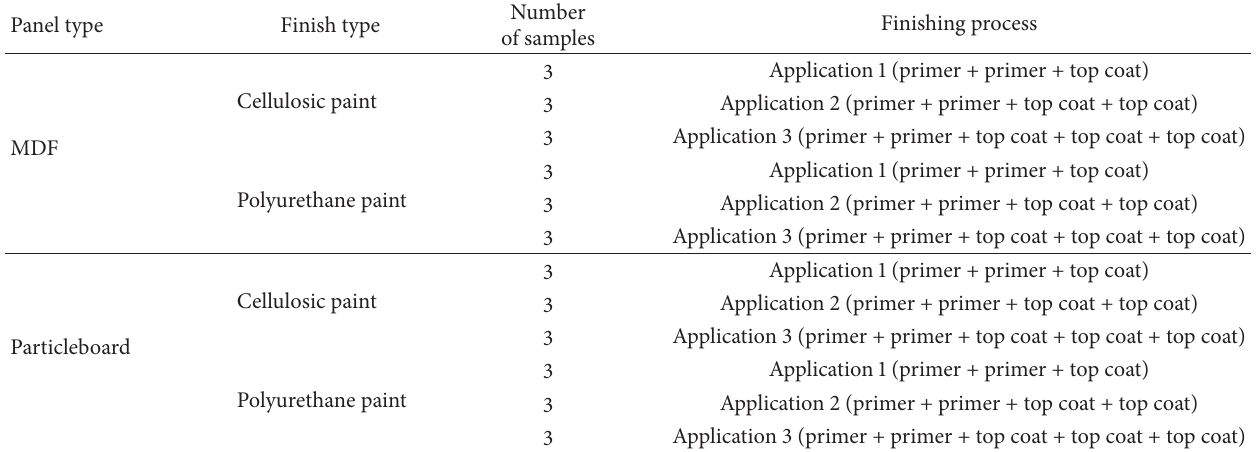
Table 2: Sampling schedule.